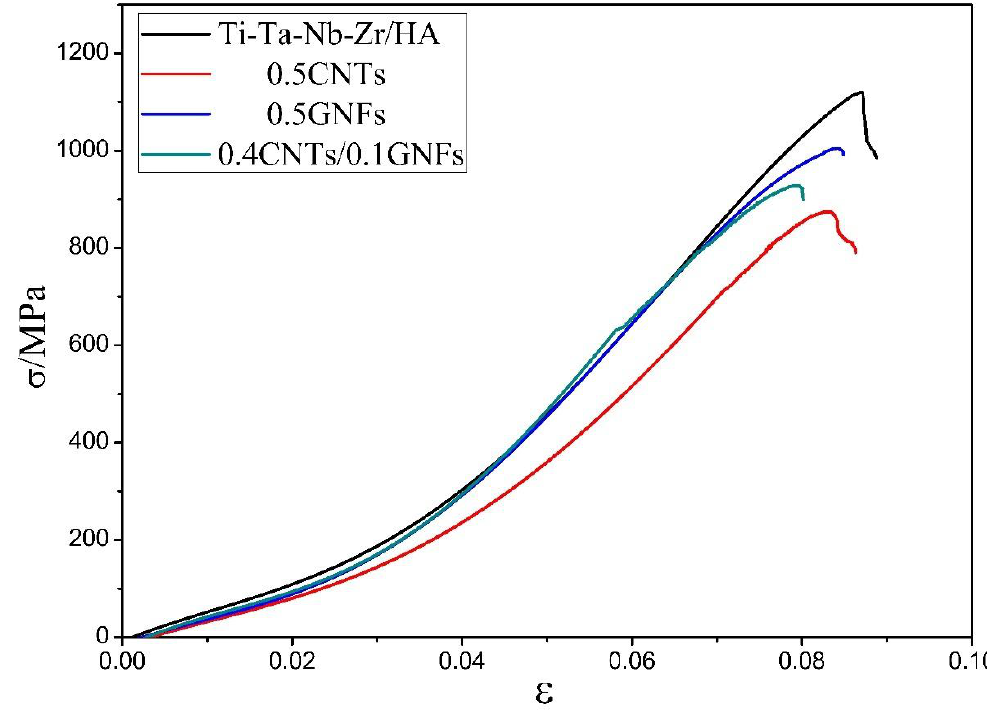
Figure 9. Compressive stress-strain curves of nanocomposites sintered at 1000 °C.